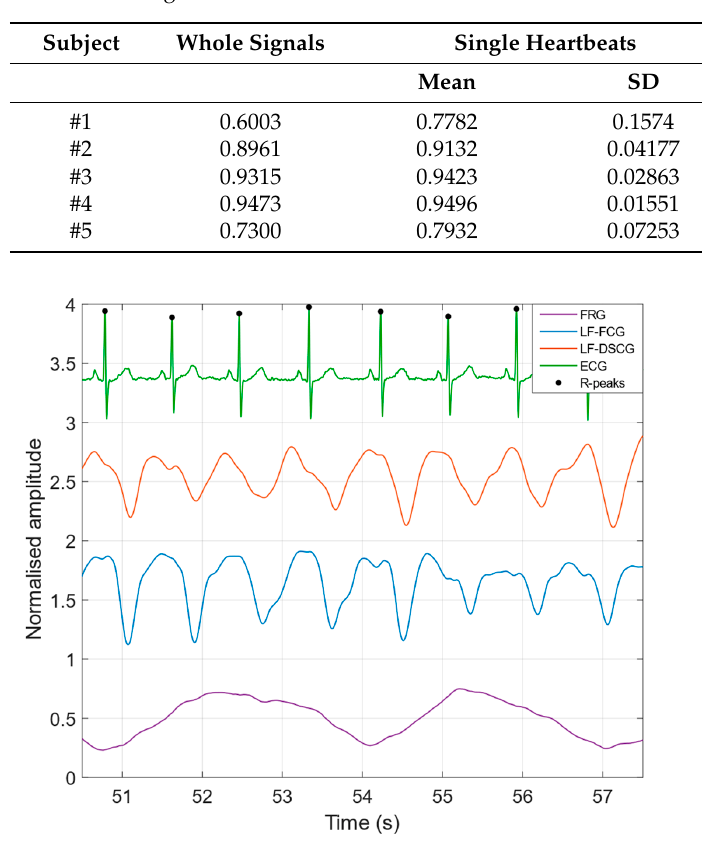
Figure 2. LF-FCG, LF-DSCG and ECG signals acquired during apneas (subject #2). Table 1. Normalized cross-correlation indices of the LF-FCG and LF-DSCG signals acquired during apneas. The correlation indices were computed between the whole signals, between single corresponding heartbeats (mean and SD of correlation indices are reported) and between the ECG-triggered ensemble averages.